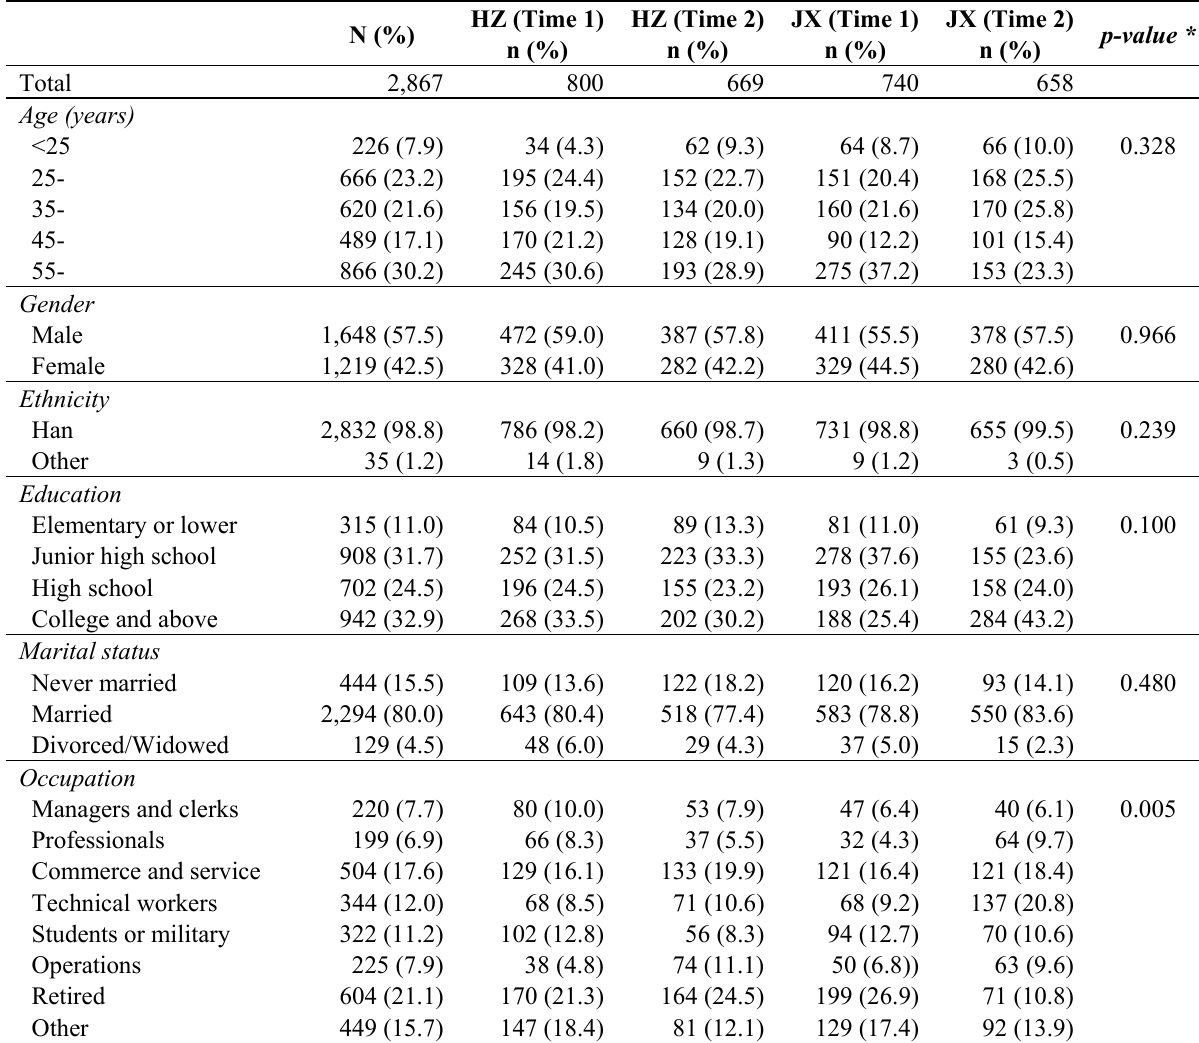
Table 1 . Sociodemographic characteristics of the study